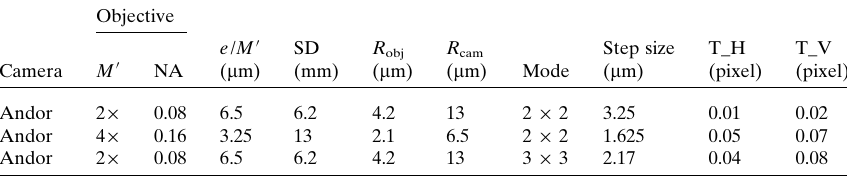
Table 5 Calculation results of the translational error in visible-light imaging experiments. SD, e / M 0 , R obj and R cam represent the sample-to-detector distance, effective pixel size, diffraction limit and camera resolution, respectively. T_H and T_V represent the maximum translational error in the horizontal and vertical, respectively. The unit ‘pixel’ refers to the pixel size of the projections for each group of